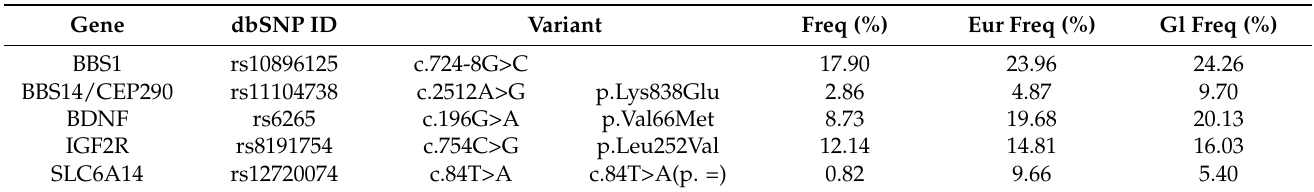
Table 6. Variants in which the frequency of the minor allele is lower than European/global frequencies.